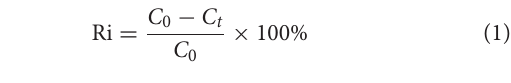
cut off rhizomes, eliminating the effect of long-distance nutrient transport. A control treatment with (8 m × 20 m) uncut plots (CK) was also included. The slope was approximately 6 ◦ . The location of the study area and field experiment design and sampling sites was shown in Figure 1